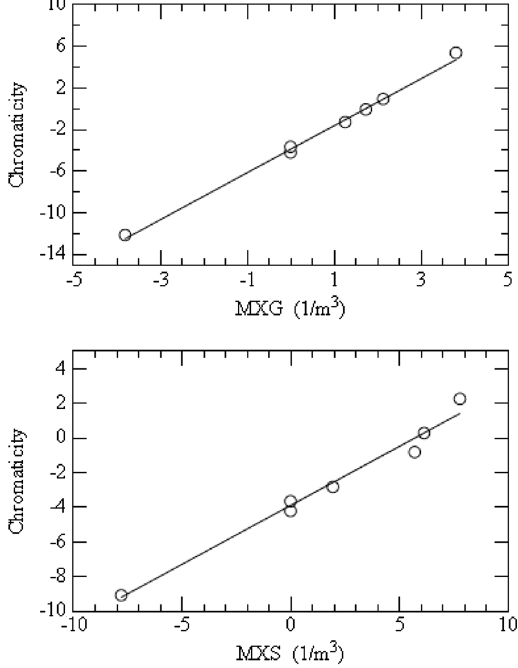
FIG. 4. Measurements of the x chromaticity as a function of the sectupole setting for either the MXG or MXS magnet families while the other was held at zero. The lines are the slices through the plane corresponding to the scan, which is a fit to all 24 chromaticity points. The field for MXL is − 0 . 145 m − 3 .